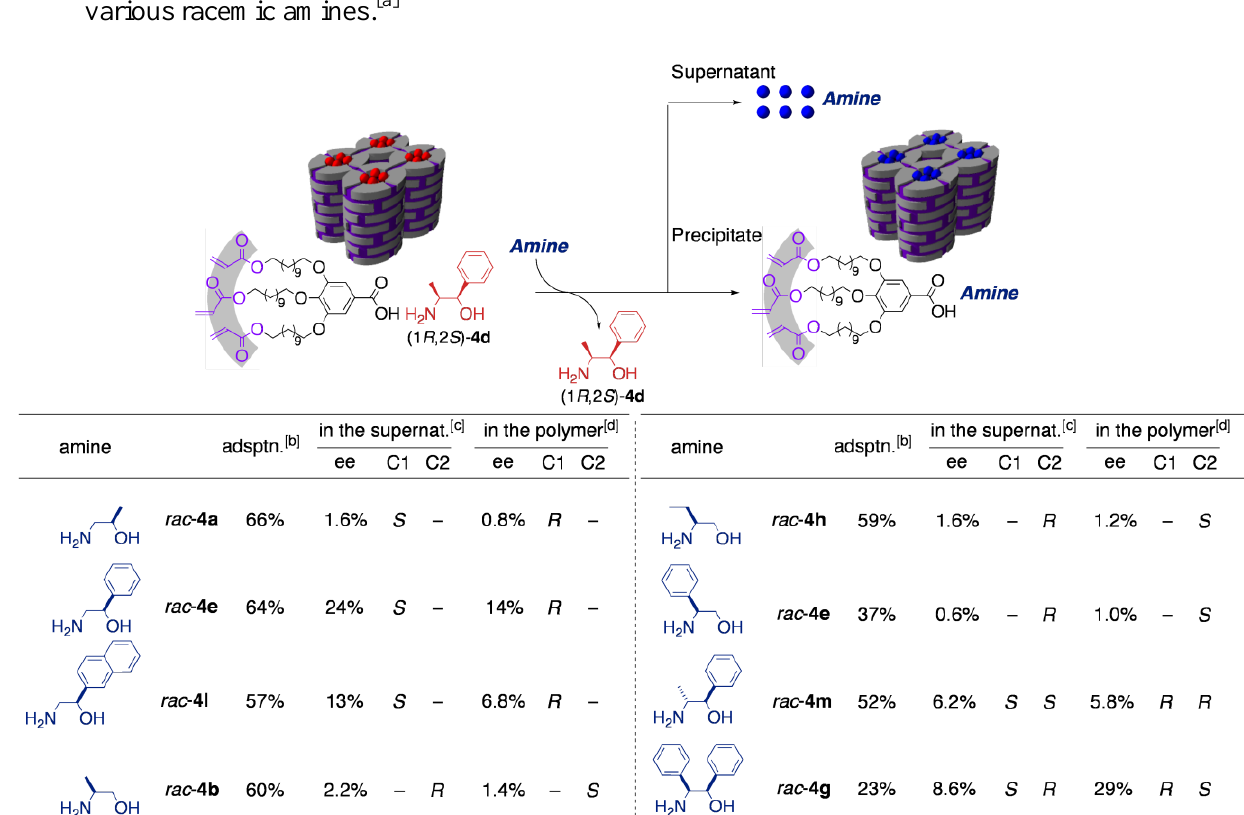
Table 3. The guest-exchanging reaction of (1 R ,2 S )- 4d in the cross-linked polymer with various racemic amines.